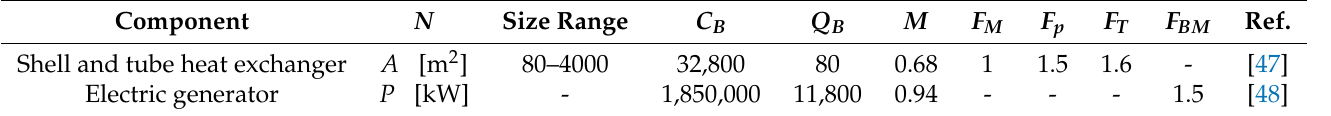
Table A3. Parameters and range of applications used in the